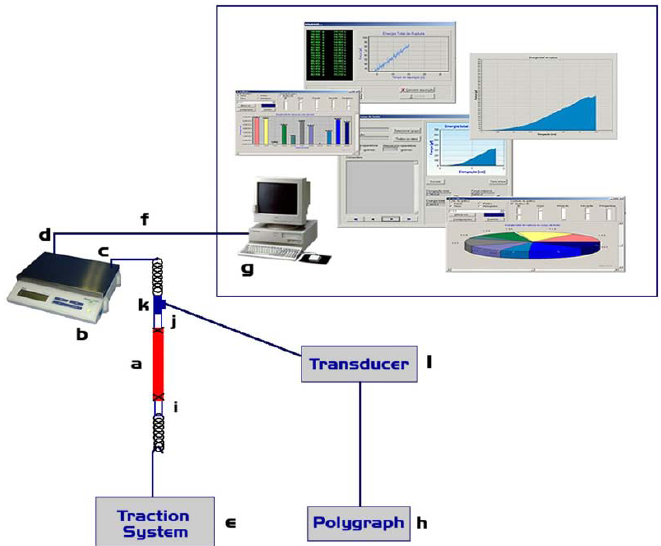
FIGURE 1 - Schematic representation of ETR. a) descendent colon segment, b) precision balance, c) strength cell, d) serial port, e) traction system, f) serial communication cable and SABI 2.0, g) computer with serial interface and SABI 2.0, h) polygraph, i) catheter cannon (closed light), j) catheter cannon (open light), k) triple-via plug attached to the